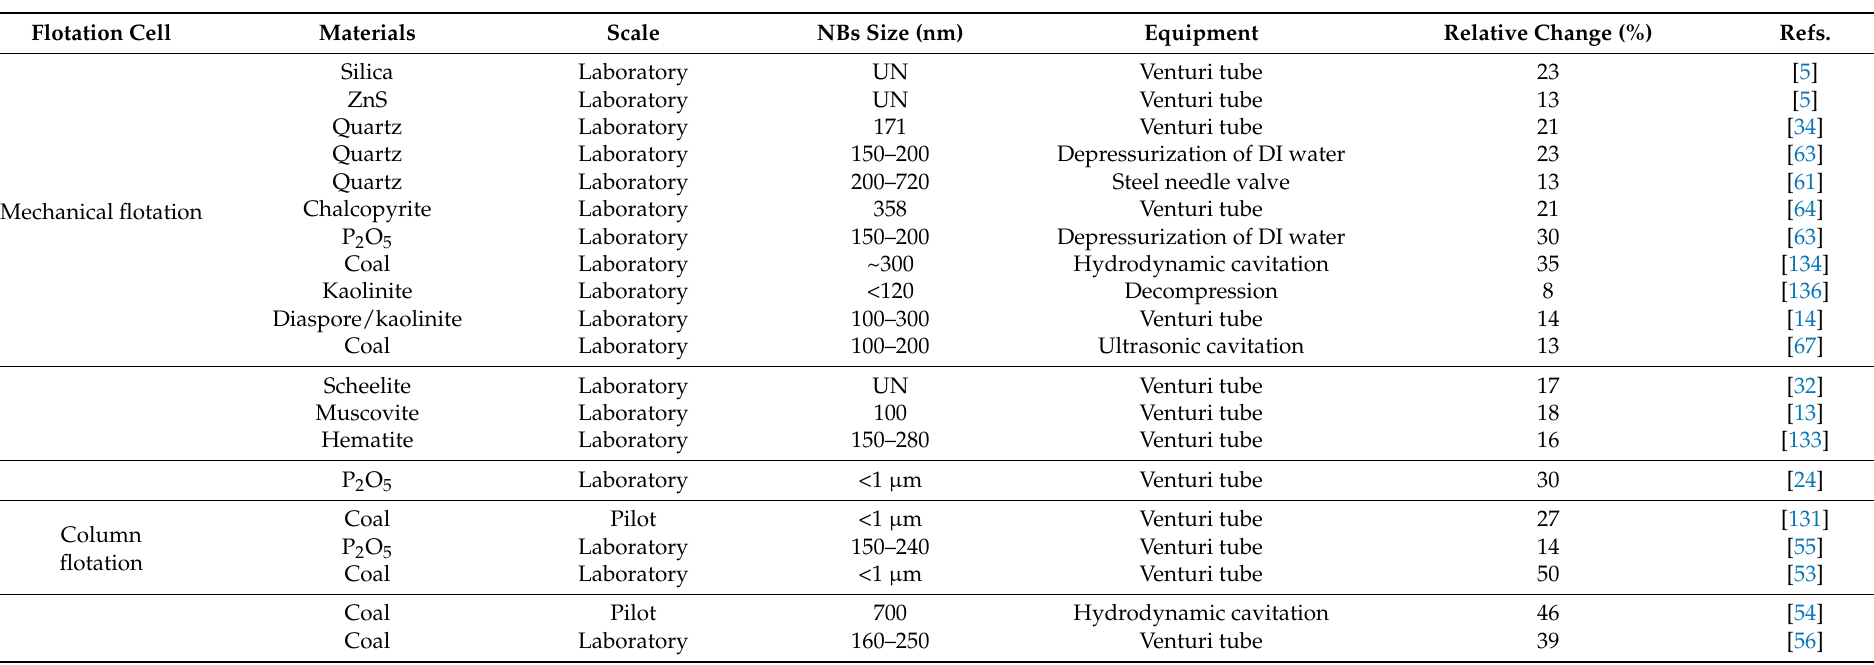
Table 4. Summary of observed change in the flotation recovery for mechanical and column flotation cases. UN: unknown or not mentioned in the